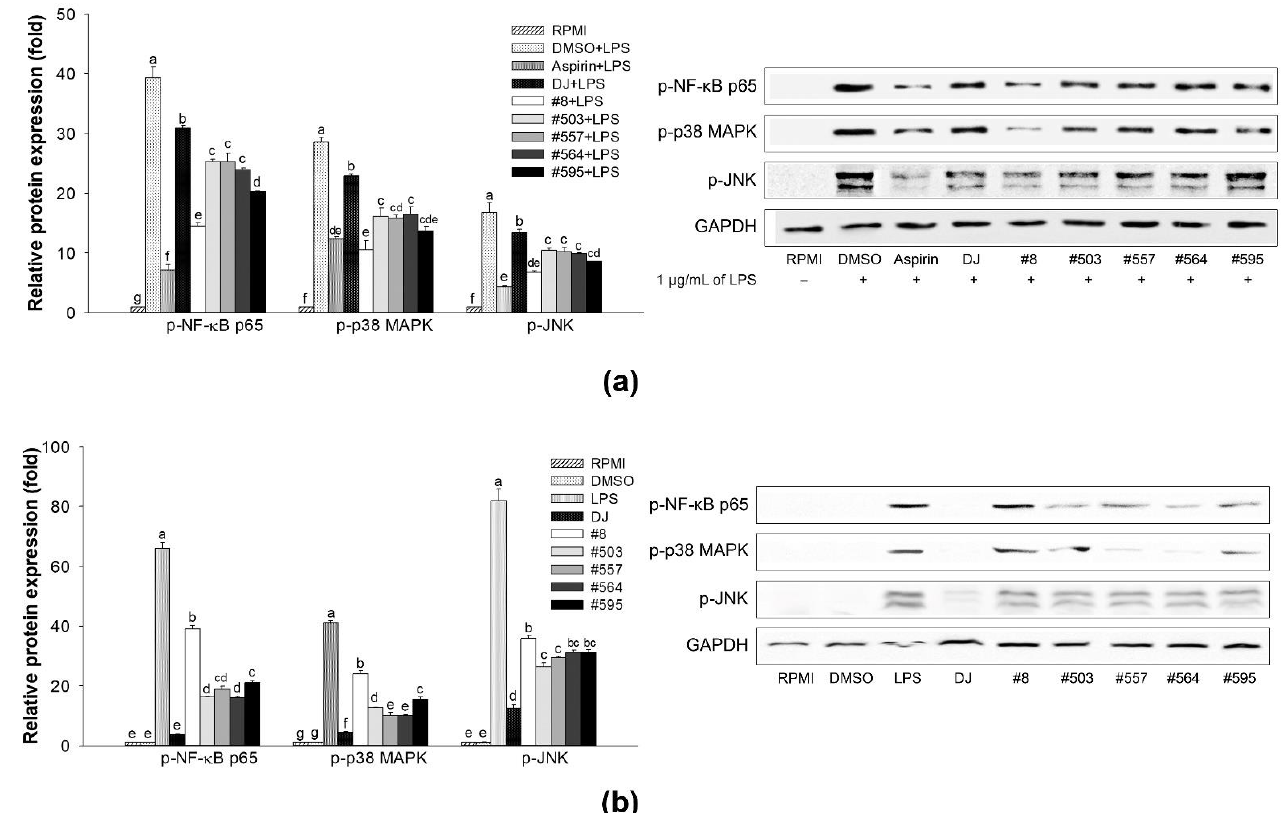
Figure 8. Effects of transgenic rice seed extracts (100 µg/mL) on the activation of the NF- κB and MAPK signaling pathways. Effects on ( a ) LPS-stimulated RAW264.7 cells and ( b ) RAW264.7 cells without LPS stimulation. The concentrations of DMSO and LPS were 0.1% and 1 µg/mL, respectively. Data are presented as means ± standard deviations. Lowercase letters (a, b, c, d, e, f, and g) indicate significant differences at p < 0.05 among the treatments.